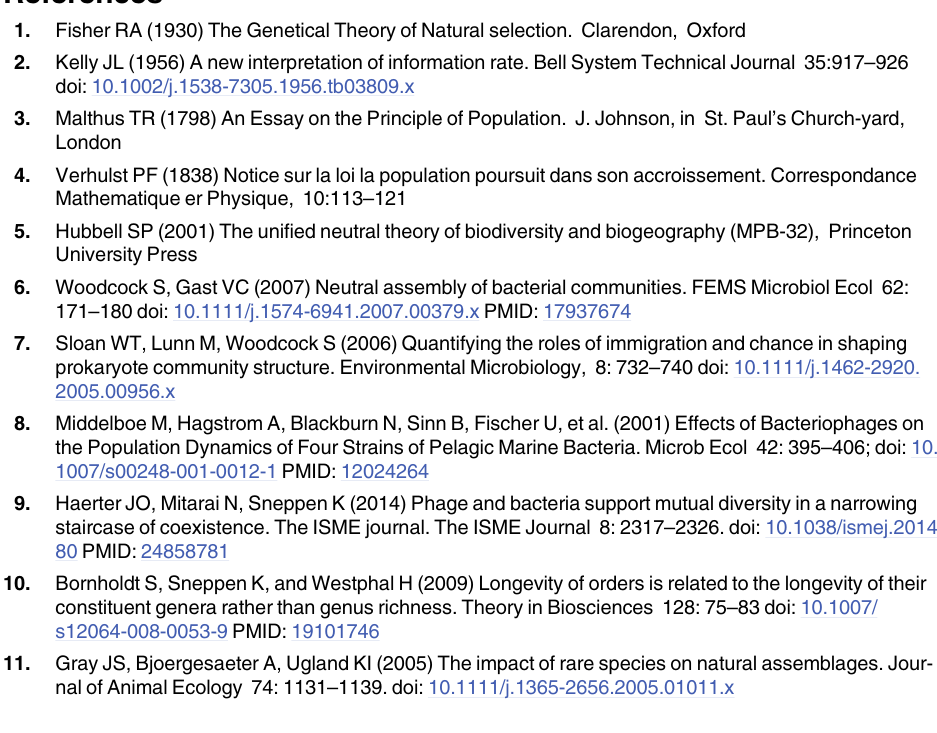
S6 Fig. Fitness model. Model variant with heterogeneous, species-specific growth rates and extinction probabilities. Each species is assigned a growth rate O i used when it repopulates the freed-up carrying capacity of the environment. It also has its own collapse probability c i . Both c O i and i are logarithmically distributed in the interval between 0.1 and 1. The purple curve in the upper panel shows the time-aggregated population distribution whereas the grey shaded area is that for the standard model where species ’ growth and collapse rates are all equal to each other. The lower panel shows the average growth rate h O i i (blue) and the average collapse probability h c i i (red shaded area) of species binned by their collected at every time step. Both curves represent time-aggregated averages of individual populations. (TIFF) S7 Fig. Resilience model. Model variant with heterogeneous, species-specific growth rates and survival ratios following a collapse. Each of N = 1000 species is assigned a growth rate O i 2 [0.1,1] and collapse size γ i 2 [10 − 9 ,10 − 2 ], both logarithmically distributed. A) The blue curve shows the time-aggregated population distribution, whereas the grey area refers to that in our basic model. B) The average growth rate h O i i (blue) and the average survival ratio h γ i i multi- plied by 200 (red shaded area) binned by the population size collected at every time step. Both curves represent time-aggregated averages of individual populations. C) The average (arithme- tic) population size as a function of species ’ survivor ratio γ i . D) The average (arithmetic) popu- lation size as a function of species ’ growth rate O i .